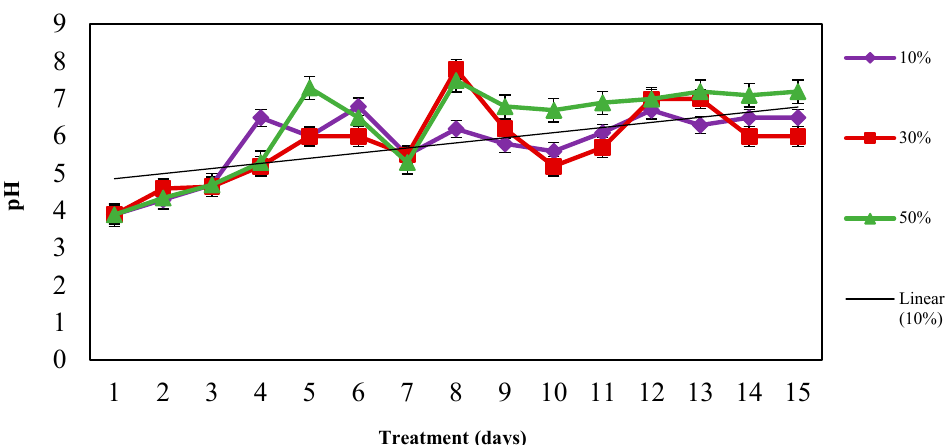
Figure 11. Daily pH value in each digester (10%, 30%, 50% and control with 10% of inoculum and no biofilm) at T = 37 °C.